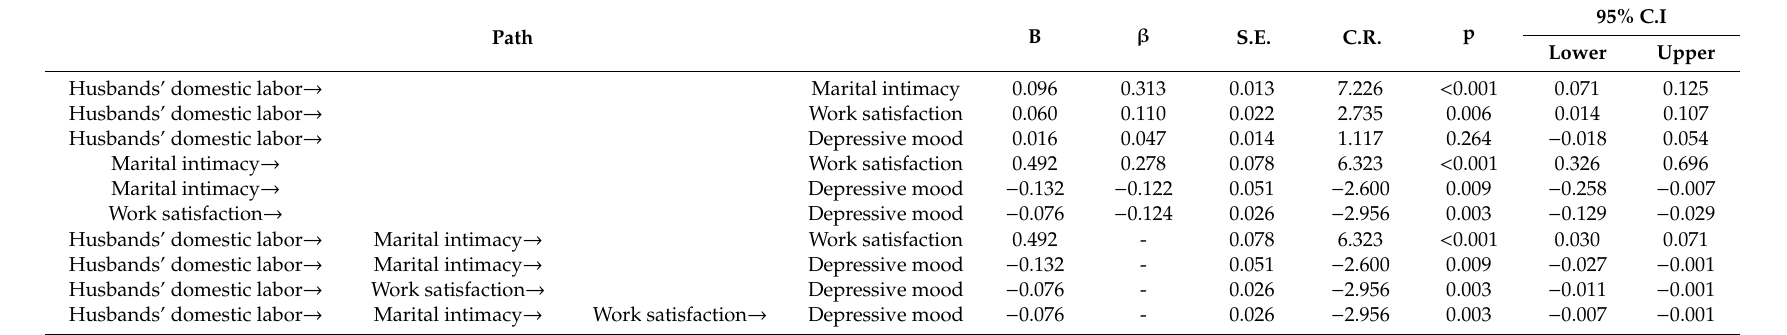
Table 5. Direct and indirect e ff ects and mediated